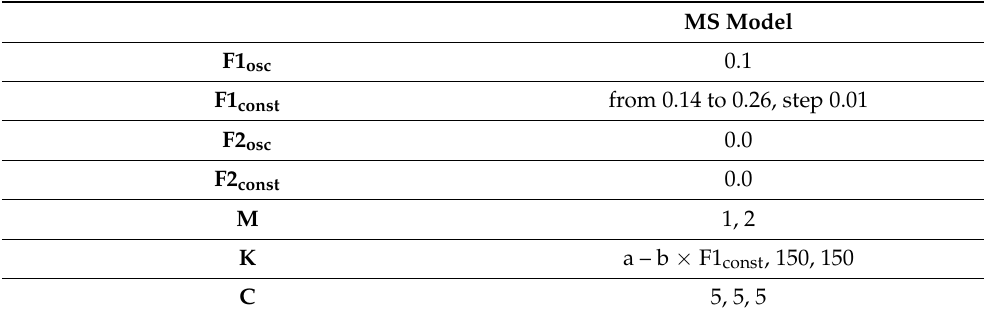
Table 2. Parameters of the MS model. Parameters as explained in Table 1. The stiffness constant k 1 depends linearly on F1 const , with a = 1275 and b =